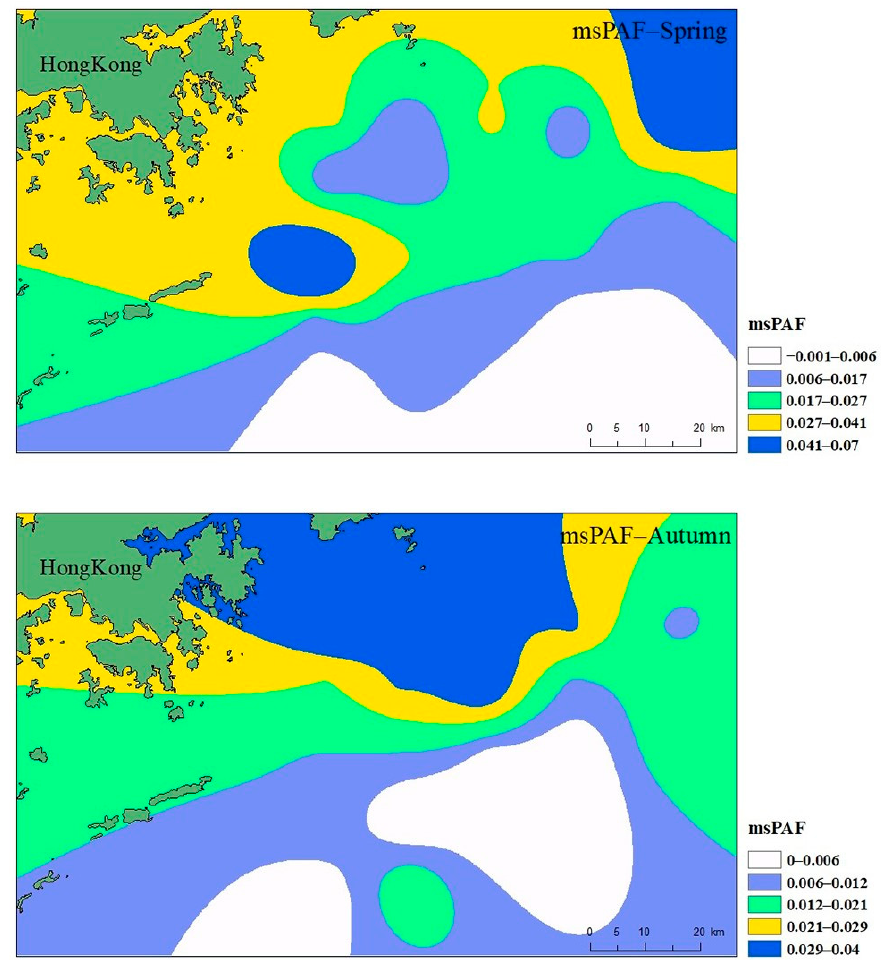
Figure 8. Compound hazard ratio (msPAF) of heavy metals in seawater of Hong Kong.